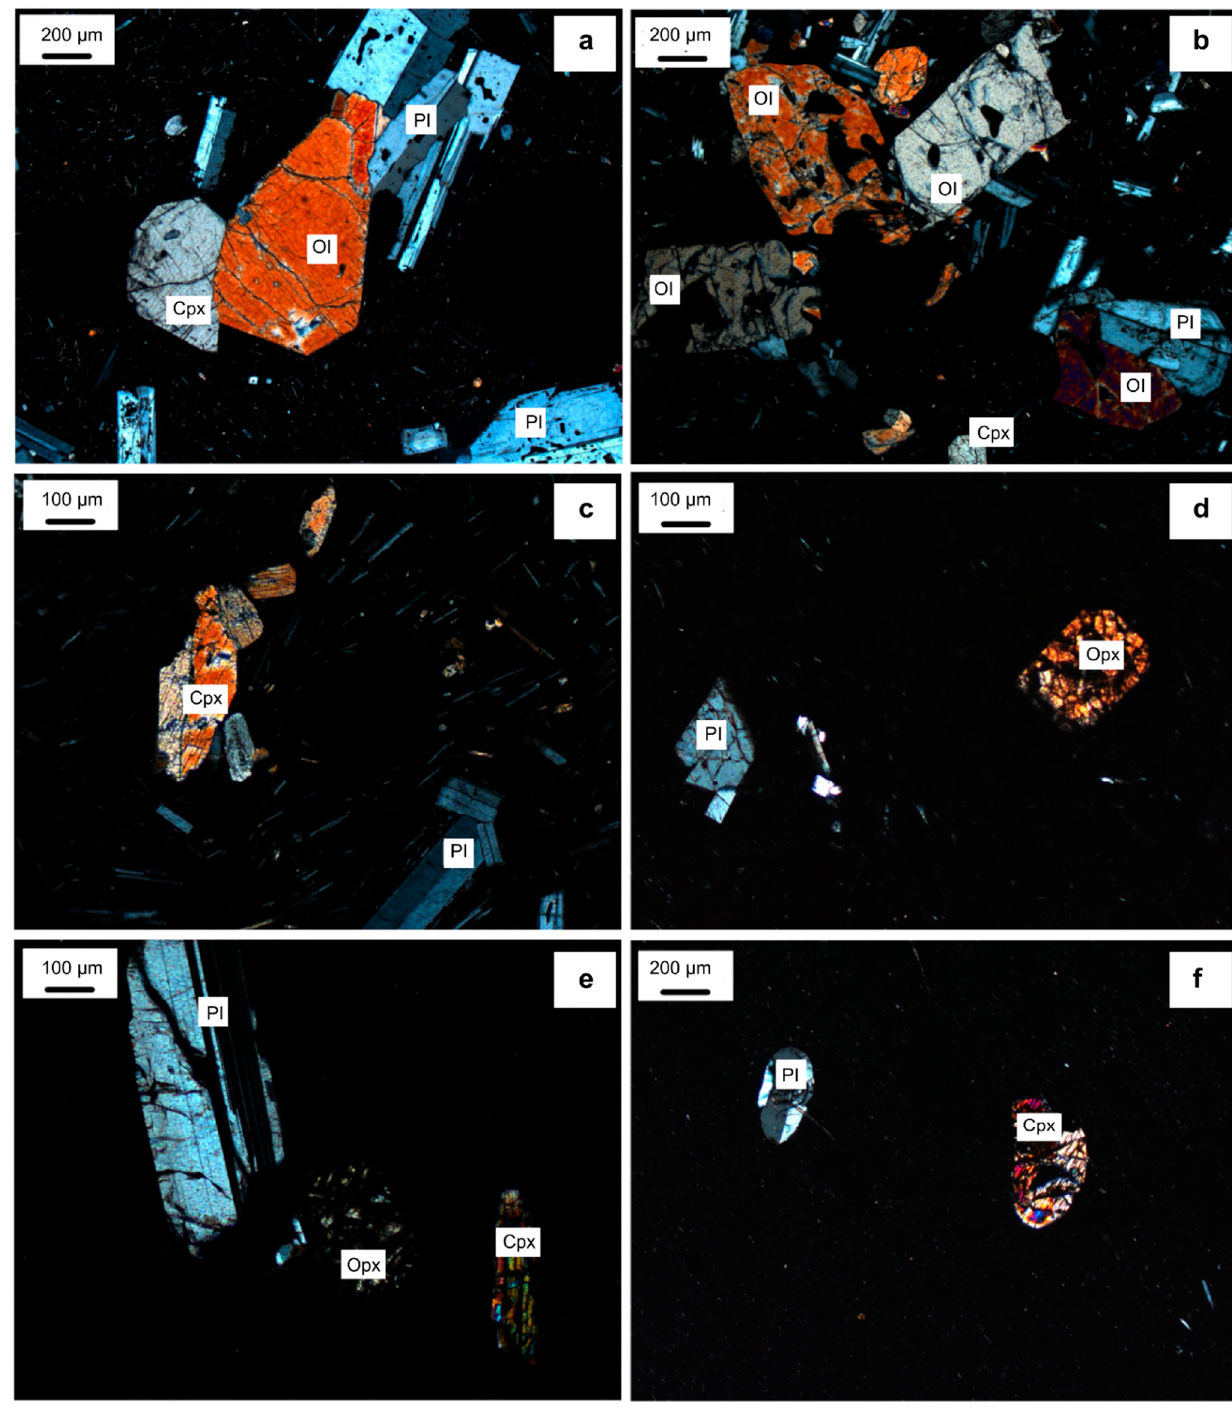
Figure 2. Representative photomicrographs of the MOT and SOT volcanic lava samples. ( a ) T9-1 is from the SOT and ( b ) R2, ( c ) T5-2, ( d ) T2, ( e ) T6-1, and ( f ) T6-2 are from the MOT. Abbreviations: olivine (Ol); magnetite (Mt); clinopyroxene (Cpx); orthopyroxene (Opx); and plagioclase